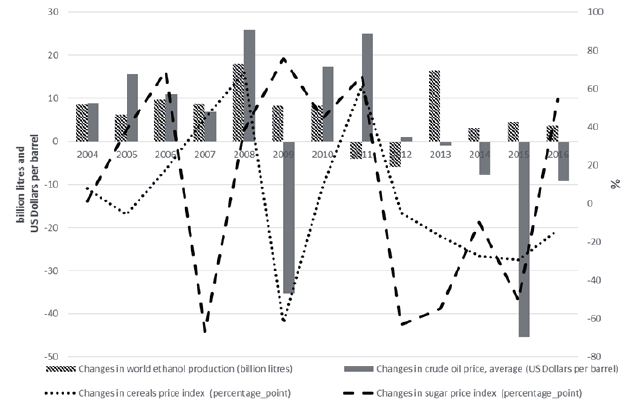
Fig. 5 – Word biodiesel production, crude oil price, vegetable oil price index (2003-2016). Source: OECD/FAO